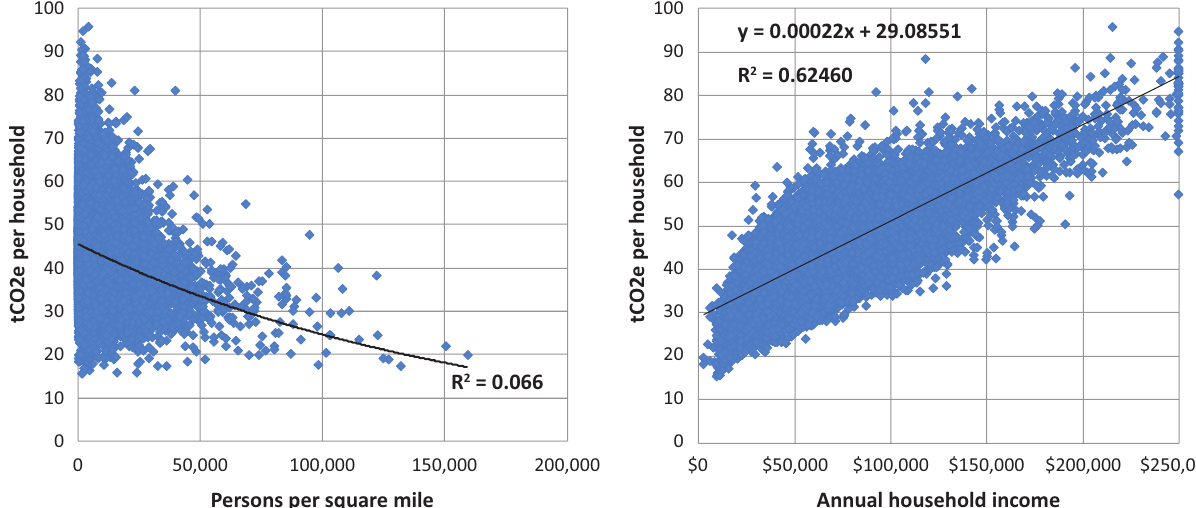
Figure 4. (Left) carbon footprint of Census block groups by population density, and (right) carbon footprints by average annual household income (right-hand